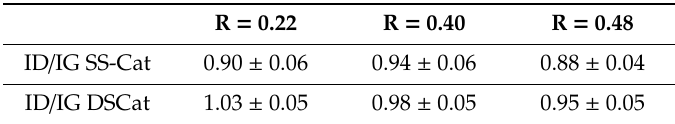
Table 4. ID / IG band ratios for SSCat and DSCat at R = 0.22, 0.40, and 0.48. Table 4. ID/IG band ratios for SSCat and DSCat at R = 0.22, 0.40, and 0.48. R =